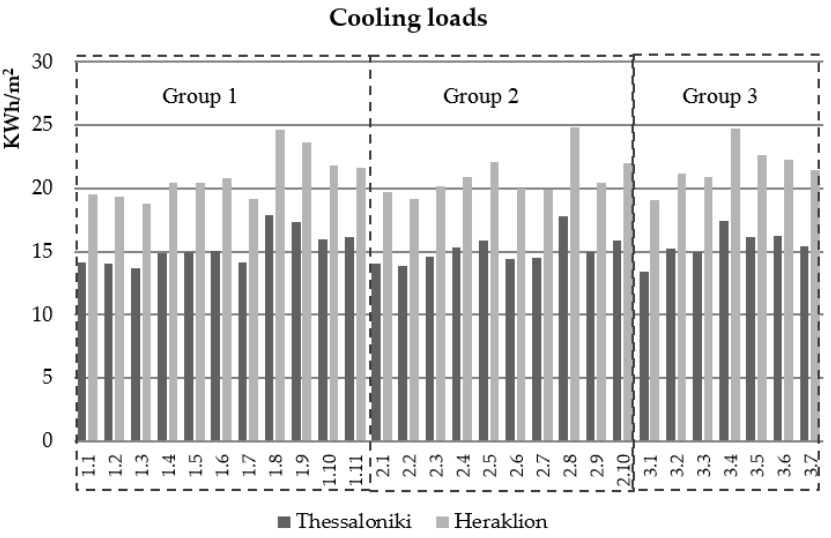
Figure 7. Cooling load demand for all examined typical urban blocks for the city of Thessaloniki and for the city of Heraklion.